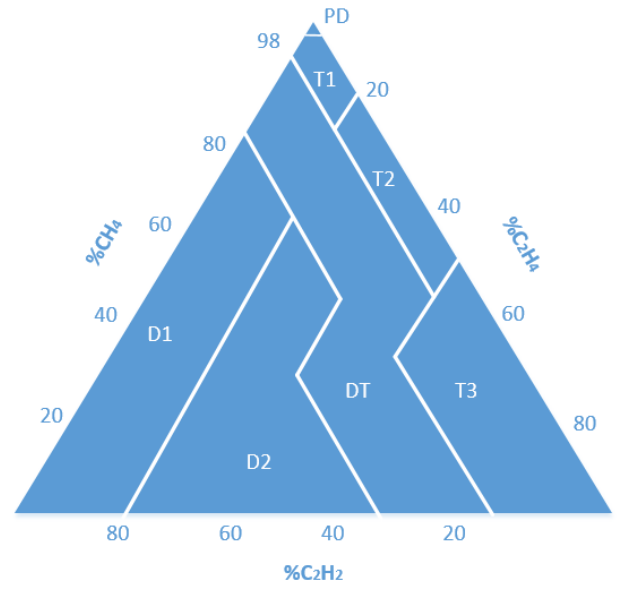
Figure 1. Coordinates and fault zones of the